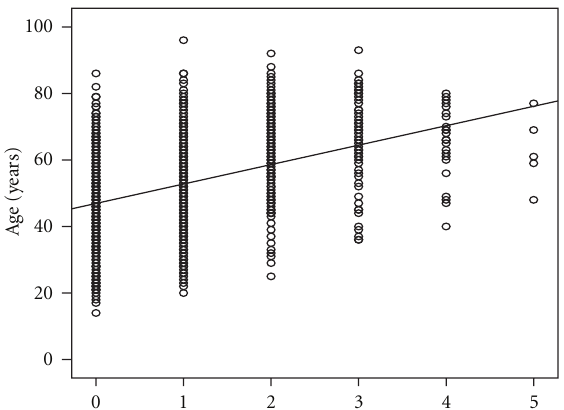
the figure correspond to di ff erent mean ages ( ± SEM) with respect to the number of degenerated discs. There is a significant increase in that number with